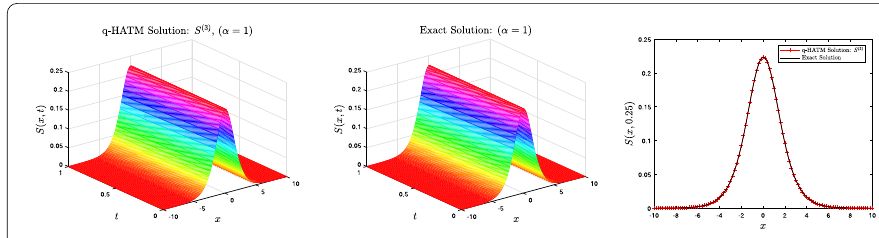
Figure 12 q-HATM vs exact solution when (cid:2) = –1, A = r = 0.1, B = 3, and n = 1 for Example 4.3